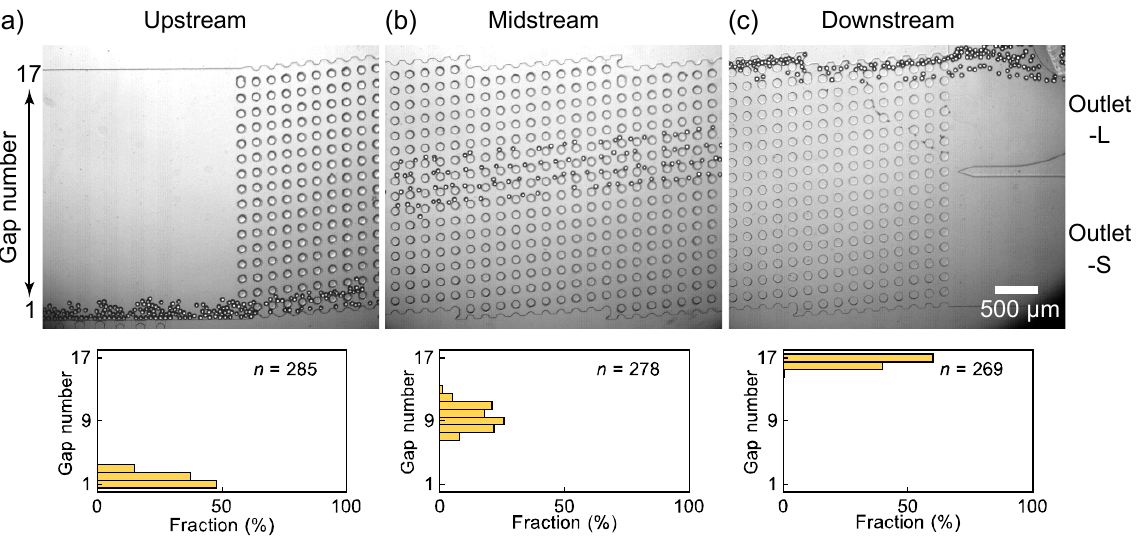
Figure 4. Spatial distribution of main droplets flowing through the DLD pillar arrays. ( a ) Main droplets entering the DLD region near the side wall. ( b ) Main droplets flowing through the midstream region in displacement mode. The droplets were counted in the 14th DLD section. ( c ) Fully displaced main droplets entering outlet-L. Flow rates were Q d = 0.1 mL/h and Q c = 10.0 mL/h. Additionally, the flow of satellite droplets through the DLD region was investigated.